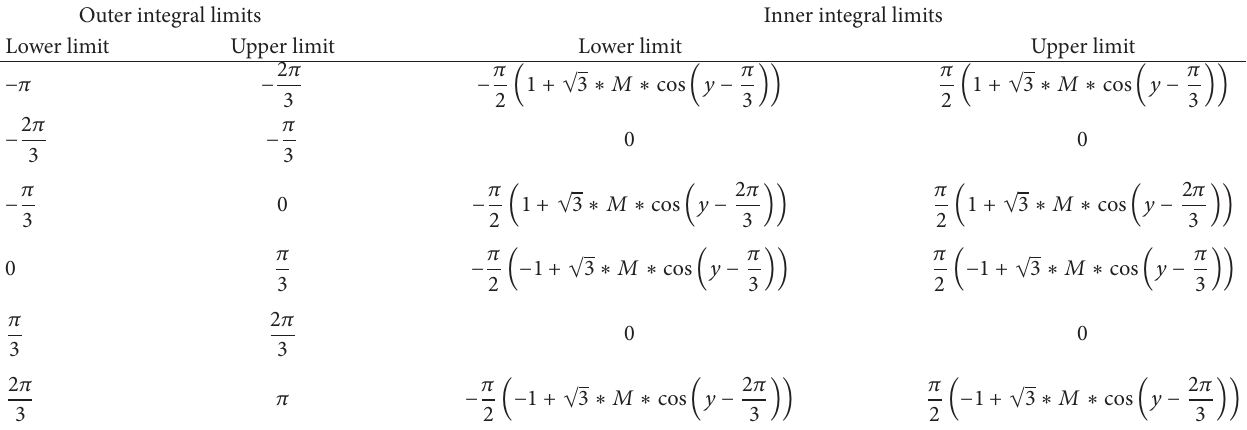
Table 2: Lists the outer and inner integral limits of the six reference waveform sections.